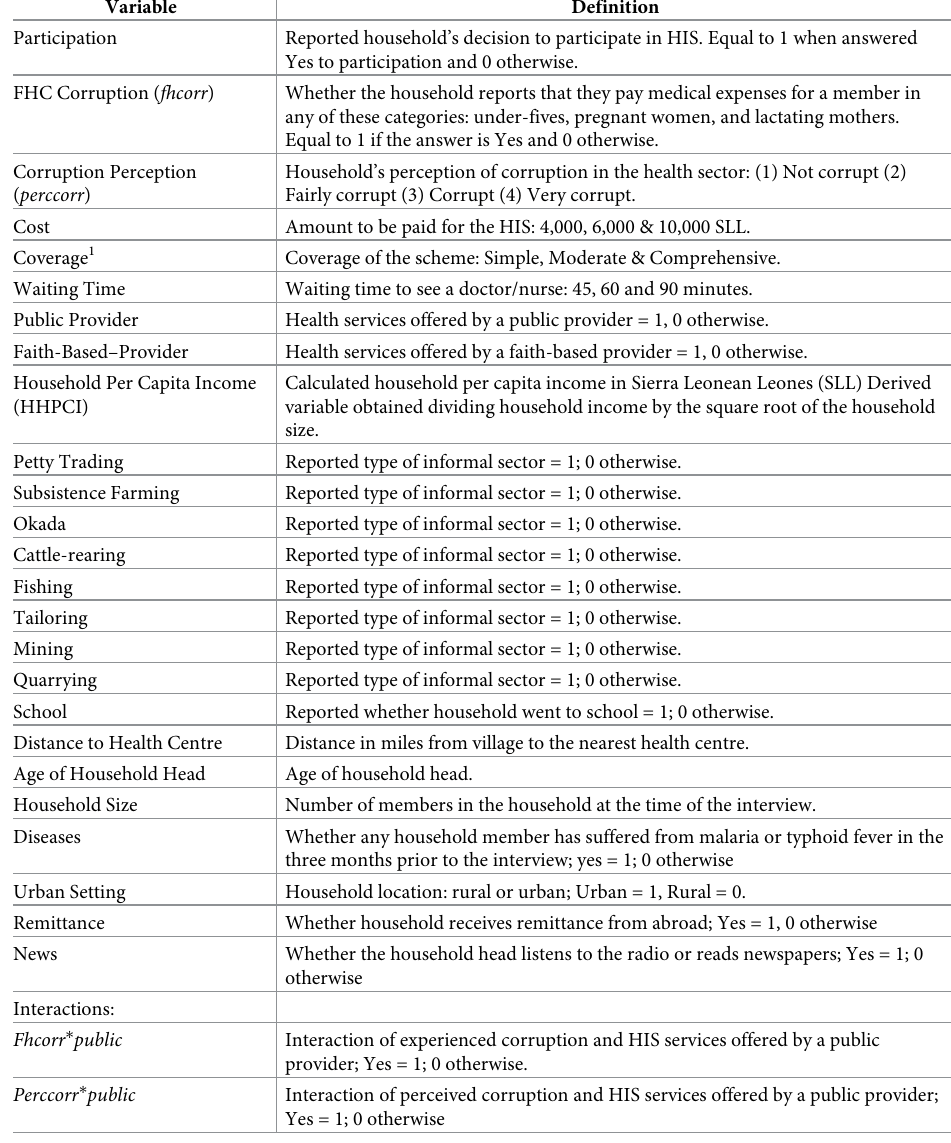
Table 2. Variable